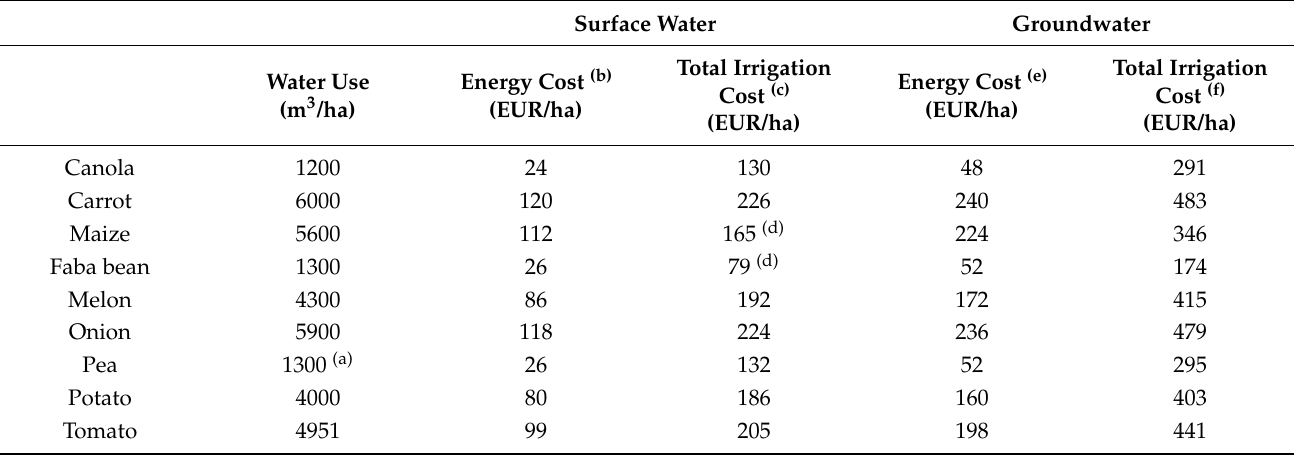
Table 5. Irrigation costs under full sunlight.